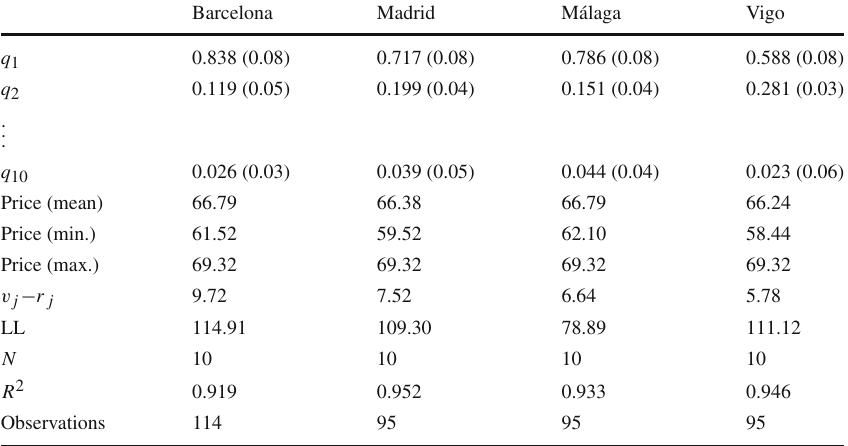
Table 5 Estimation